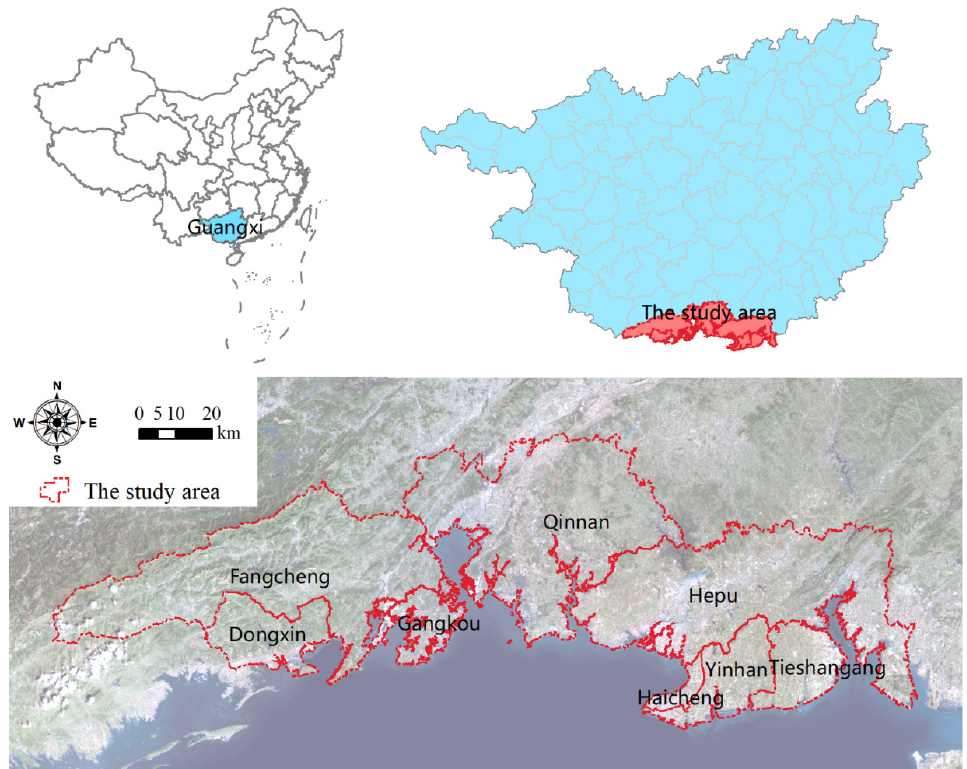
Figure 1. Location of Beibu Gulf area in China.